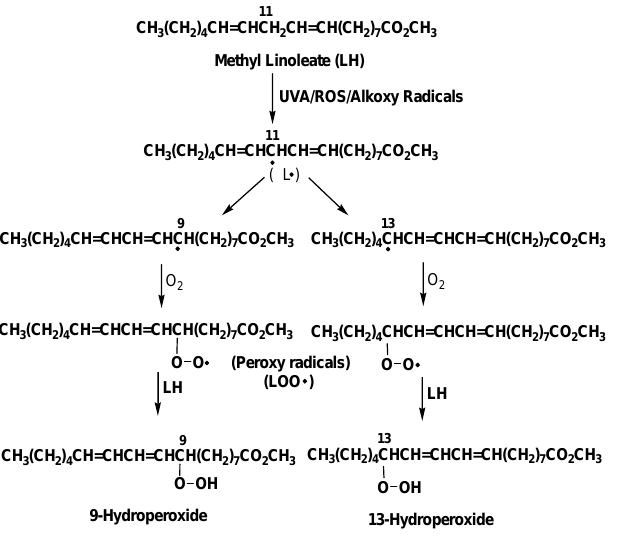
Figure 3: Peroxidation of methyl linoleate into the isomeric 9- and 13-hydroperoxides.